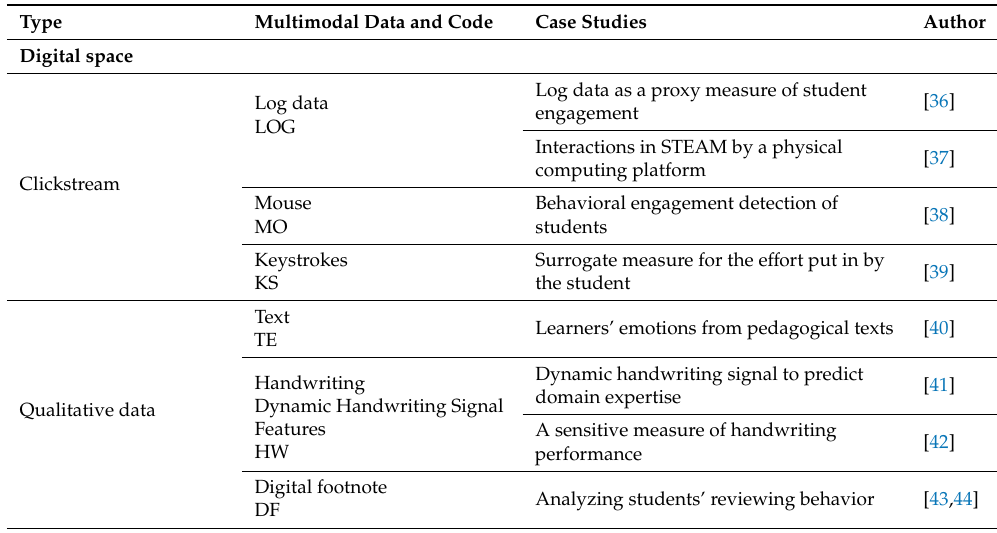
Table 3. Multimodal data classification and case